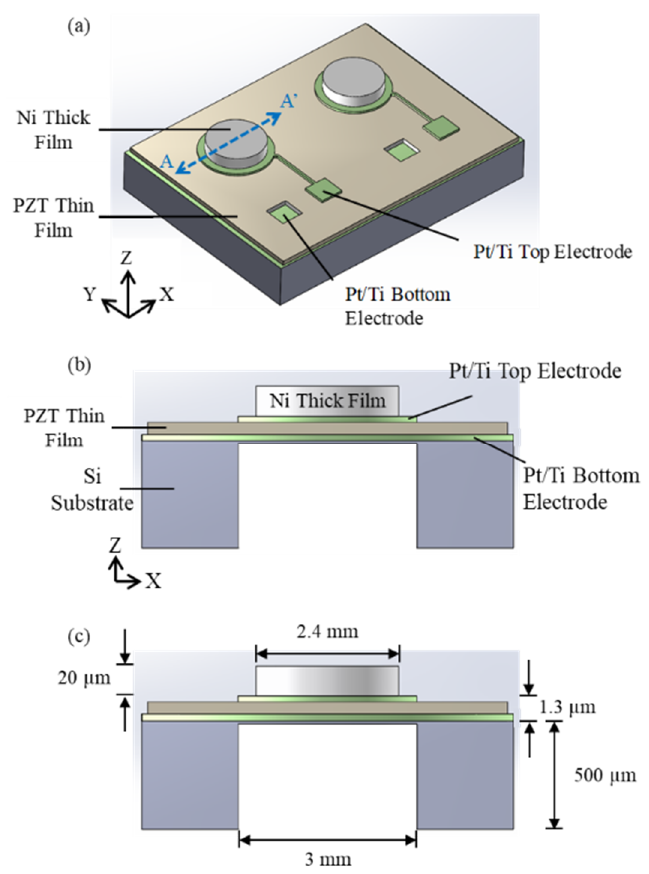
Figure 1. Illustration of the sensor: ( a ) isotropic view, ( b ) cross-sectional view along AA’ line in (a), and ( c ) dimensions of the sensor.